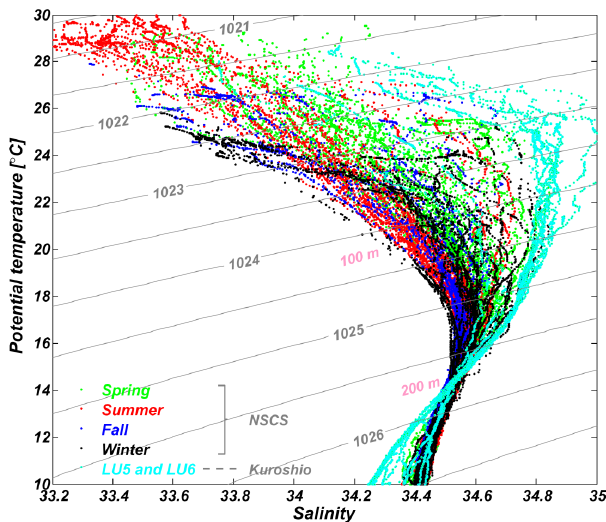
Fig. 2. Potential temperature ( θ ) versus salinity ( S ) plots ( θ - S dia- gram) in the upper 400m of the water column for the sampling sta- tions in the central northern South China Sea (NSCS) during four seasons and along sections LU5 and LU6 in spring. Also marked are the depths of 100m (density 1024.2kgm − 3 ) and 200m (den- sity 1025.6kgm − 3 ) in the central